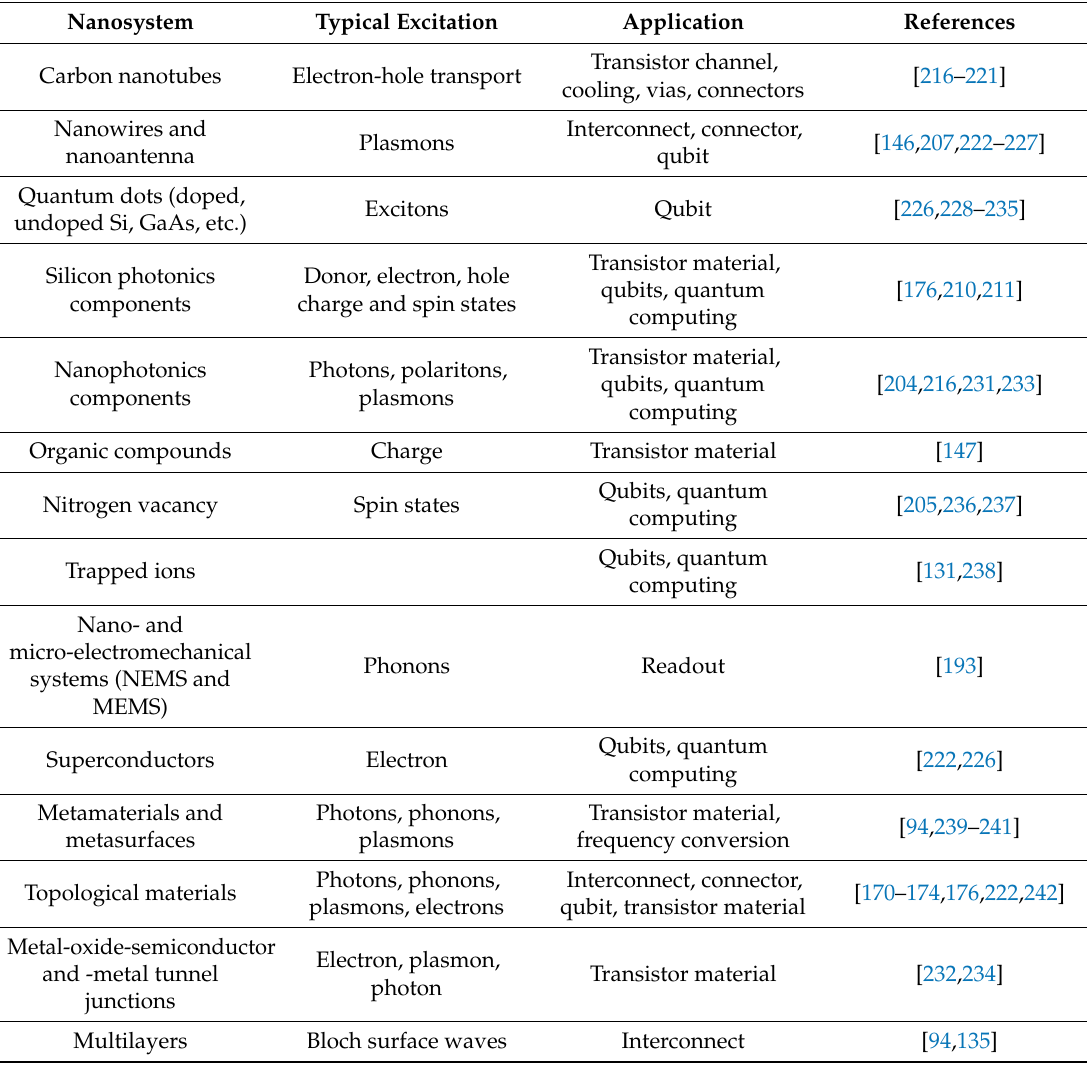
Table 1. Novel nanomaterials and nanostructures of importance in the research and development of the next-generation computing